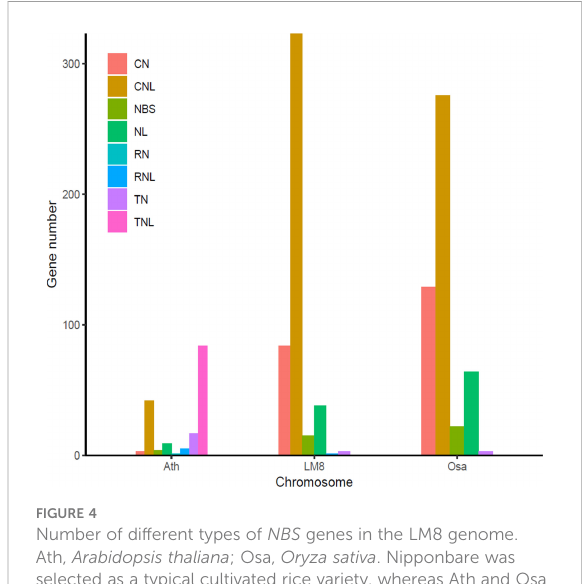
FIGURE 4 Number of different types of NBS genes in the LM8 genome.